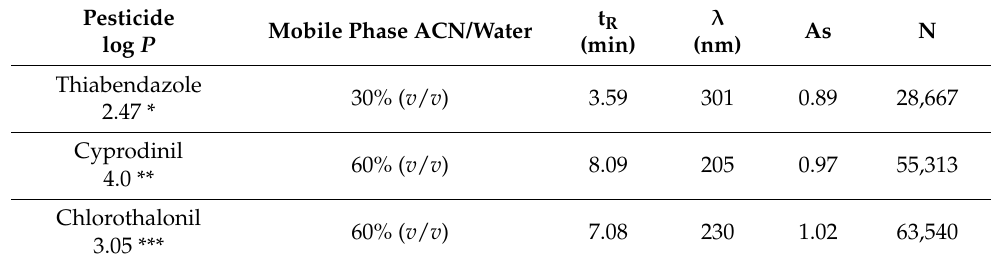
Table 1. The HPLC conditions with the chromatographic parameters obtained for the